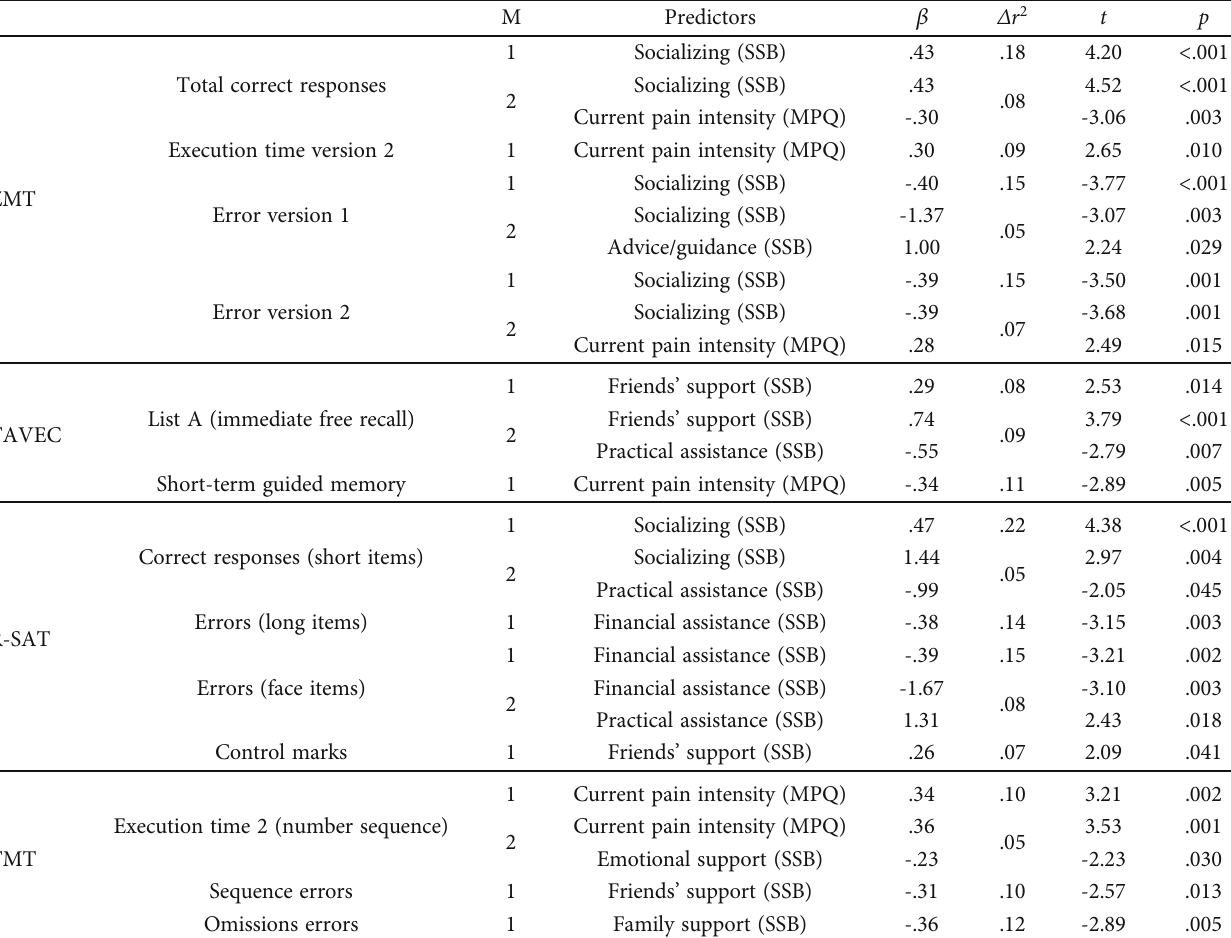
Table 4: Signi fi cant results of the second block (step-wise method) of the multiple regression analysis for the prediction of neuropsychological test scores by clinical pain and social support variables in FMS patients ( N = 64